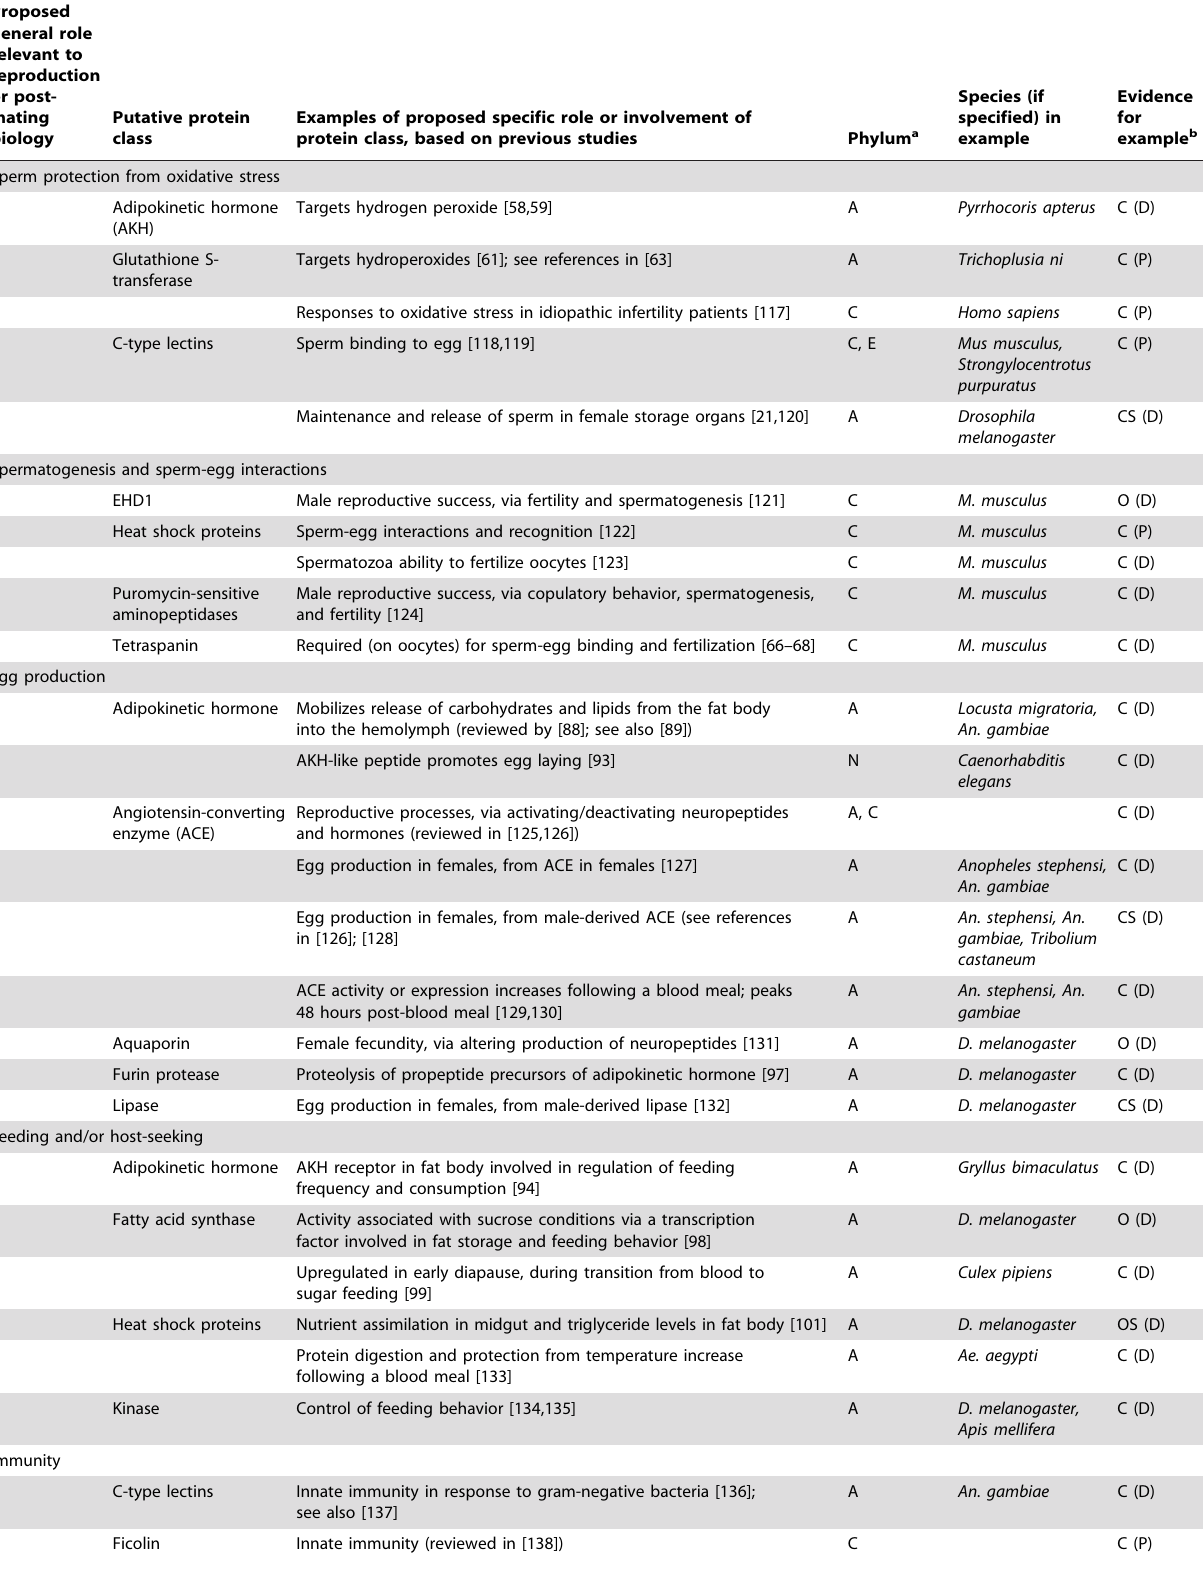
Proposed general